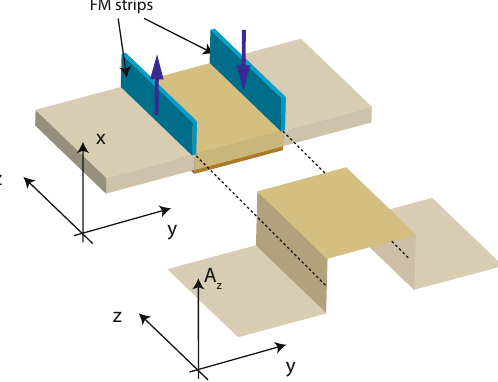
Figure 6. ( a ) A schematic of the tunneling setup with the inclusion of antisymmetrically magnetized FM strips, and ( b ) a plot of the corresponding z component of the EM vector potential which is proportional to the k z